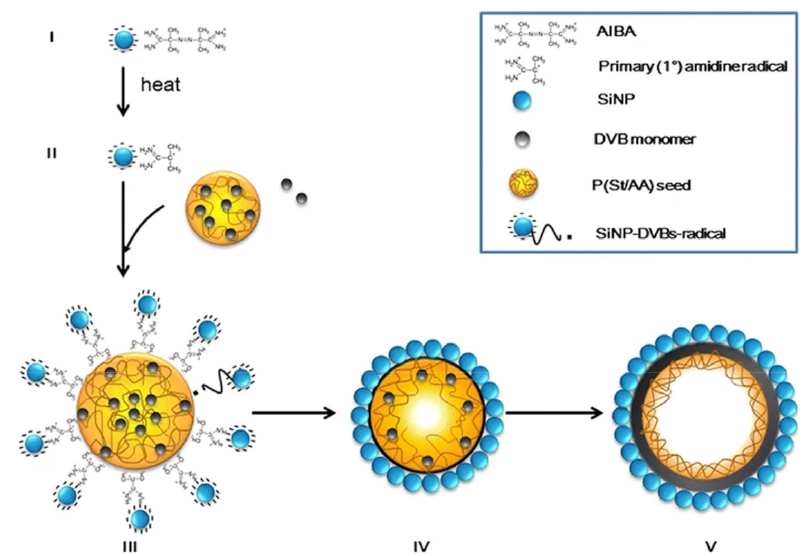
Figure 8. Proposed mechanism of the formation of hybrid HL–SiNPs particles prepared using seed/DVB. Reproduced from [63] with permission from Springer